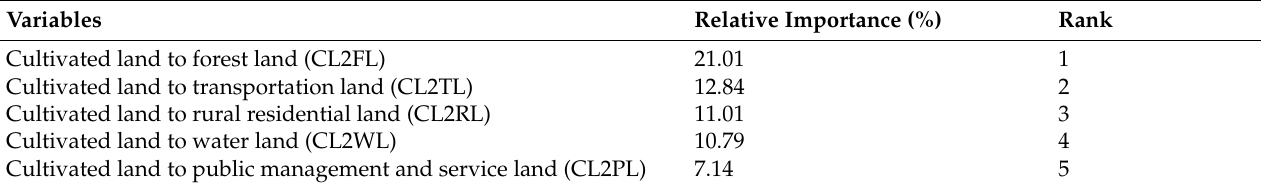
Figure 10. The antagonism relationship of WED in the economic development.